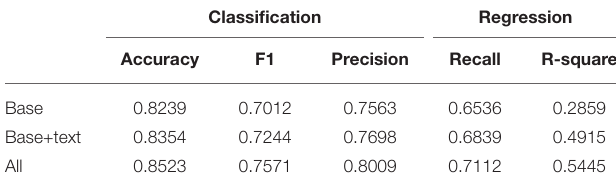
TABLE 3 | XGBoost performance